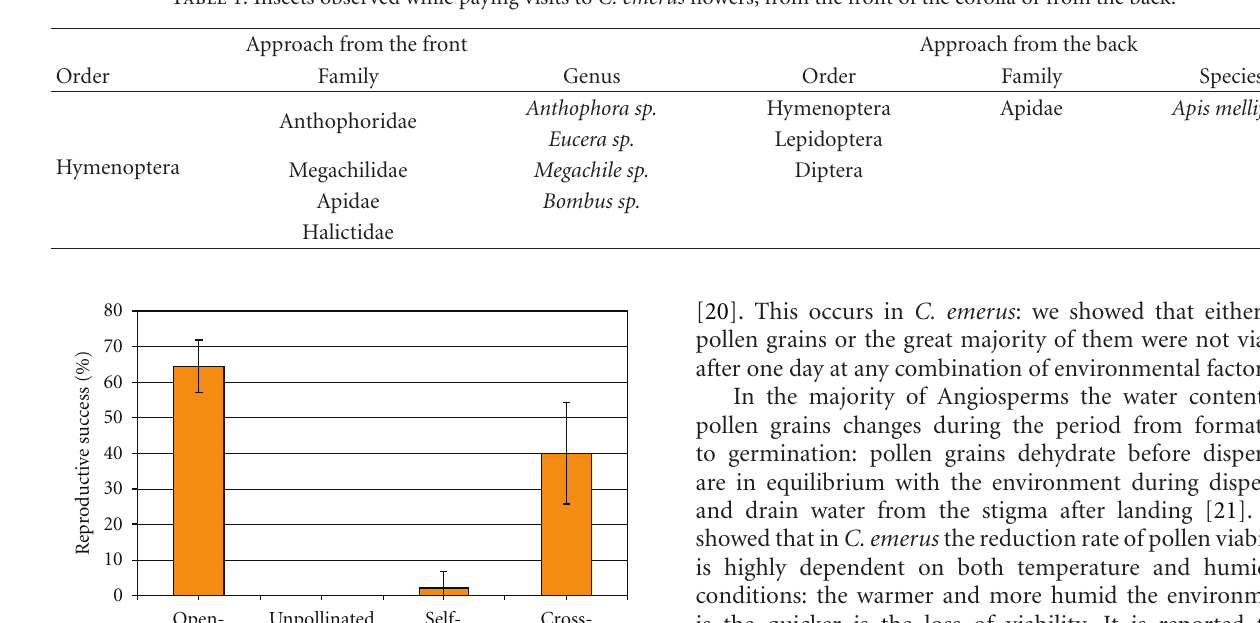
Table 1: Insects observed while paying visits to C. emerus flowers, from the front of the corolla or from the back.